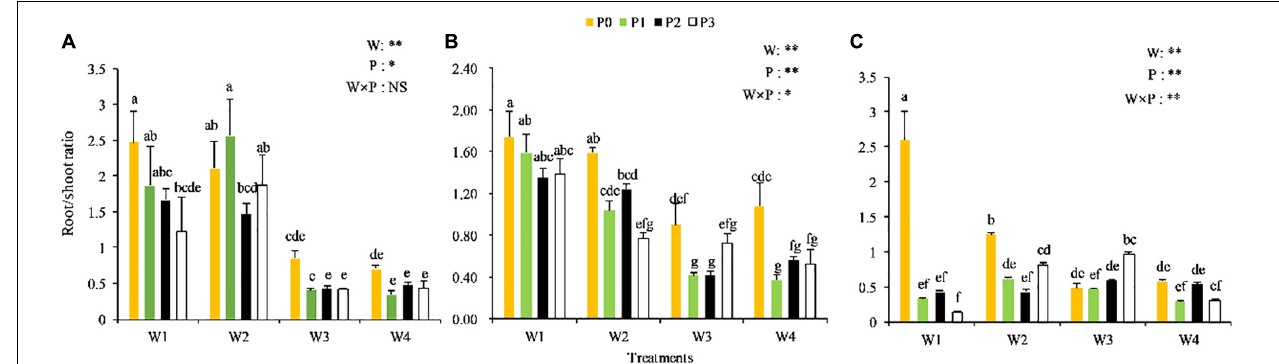
FIGURE 1 | Root/shoot ratio of Chinese milk vetch (CMV) at the different soil moisture contents and levels of added phosphorus. (A–C) Represents the seedling stage, branching stage, and full-flowering stage, respectively. In the legend, W represents the effect of soil moisture, P represents the influence effect of phosphorus application rate change, and W × P represents the interaction between soil moisture and P application. *Means the difference is significant at the 0.05 level, and **Means the difference is significant at the 0.01 level. The lowercase letter above the column in the bar chart have no significant difference for the same ones, while there are significant differences for different ones. The same as Figures 2 , 3